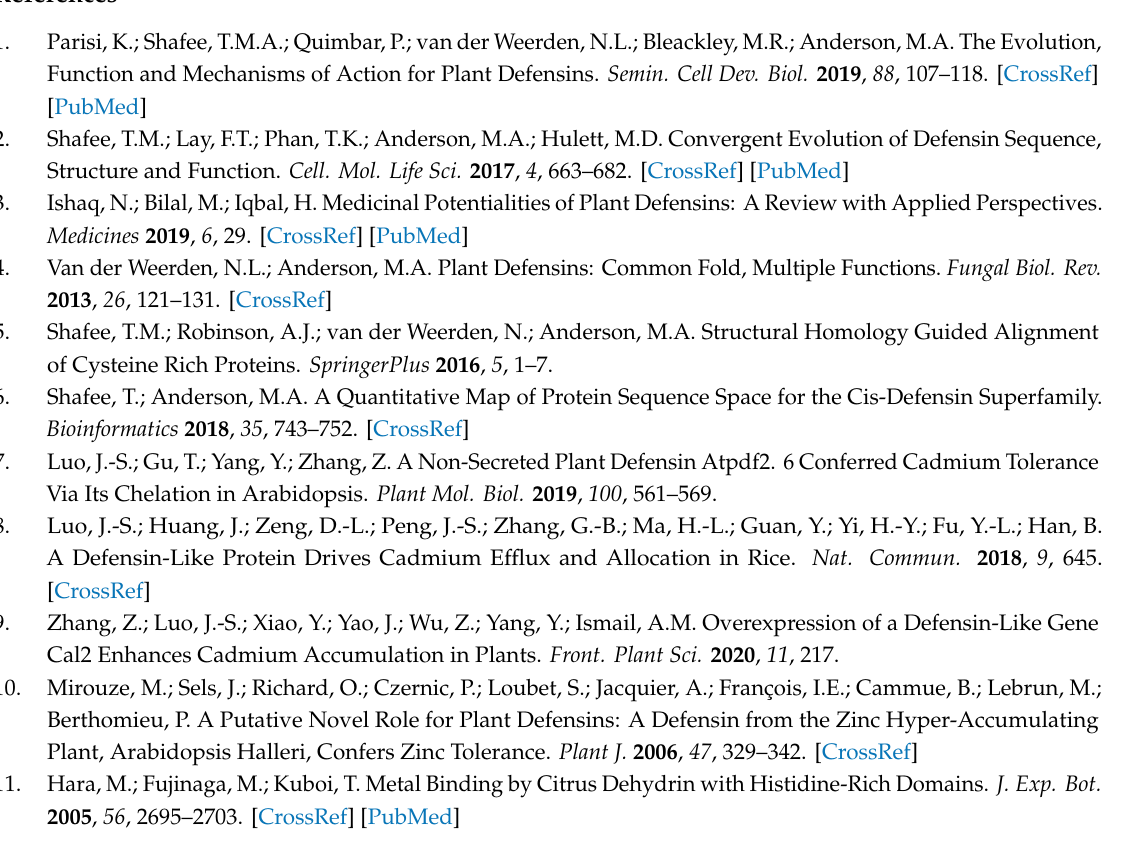
Table S1: Primers used for cloning CDS into pPink, Table S2: Statistical analysis of HRD structures, Figure S1: Sequence alignment of HRDs from N. benthamiana and A. thaliana , Figure S2: Alignment overviews for HRDs, Figure S3: Tissue-specific expression of example HRDs, Figure S4: Antifungal activity graphs for HRDs, Figure S5: Overlay of the 20 lowest-energy states for SlD26 and